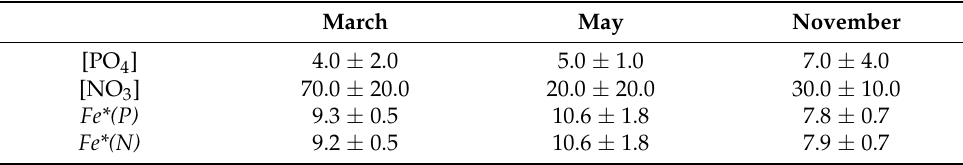
Table 4. The average [PO 4 ] and [NO 3 ] levels (unit: µ g/L) as well as Fe*(P) and Fe*(N) (unit: nM) in Sishili Bay in 2018.